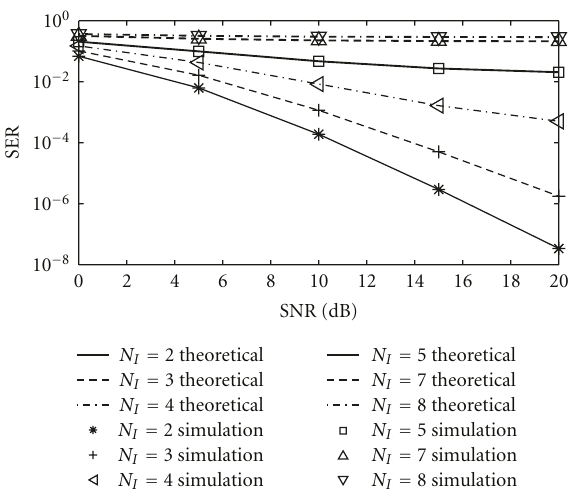
Figure 2: SER versus average SNR with di ff erent values of N I when L = 4, K = 6, and SIR =